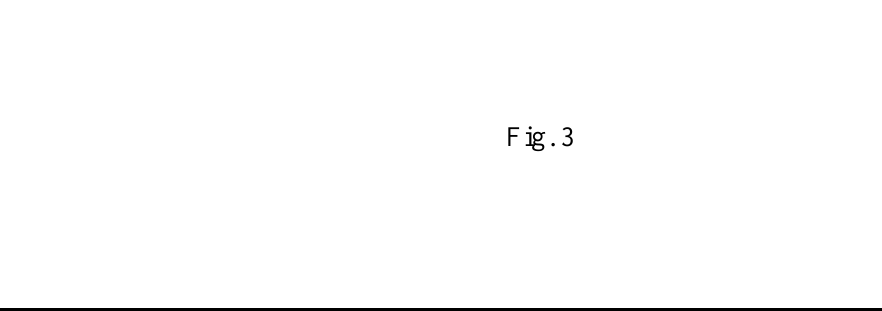
Fig.3 : Normal Sinus Rhythm on Day - 3